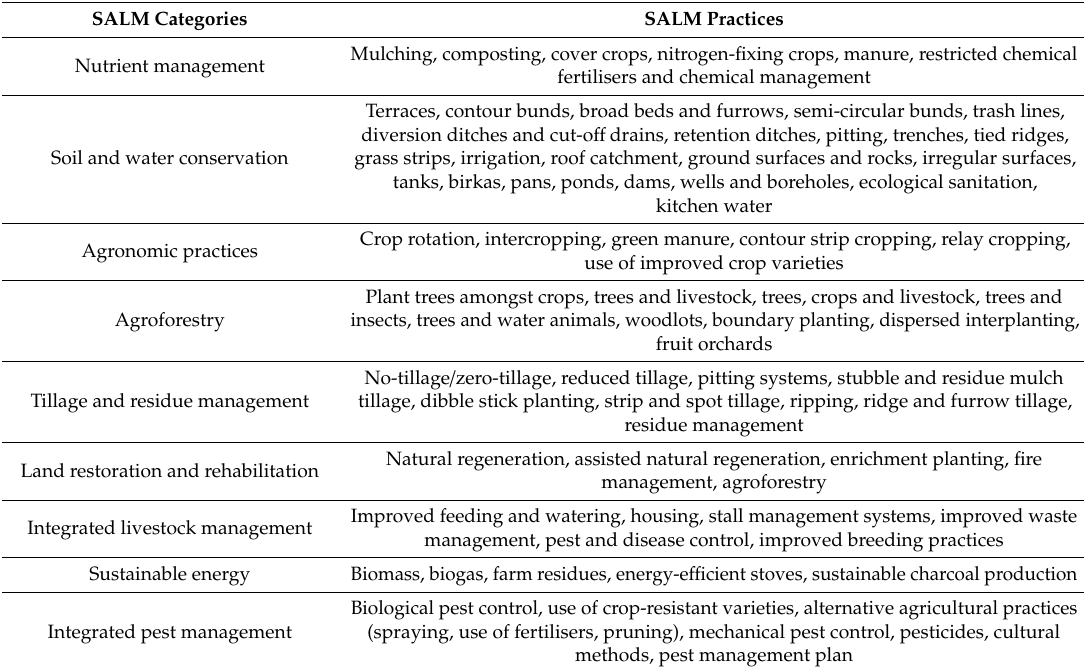
Table A1. Sustainable Agricultural Land Management (SALM) practices promoted and implemented in the Kenya Agricultural Carbon Project (KACP) (after [31]).